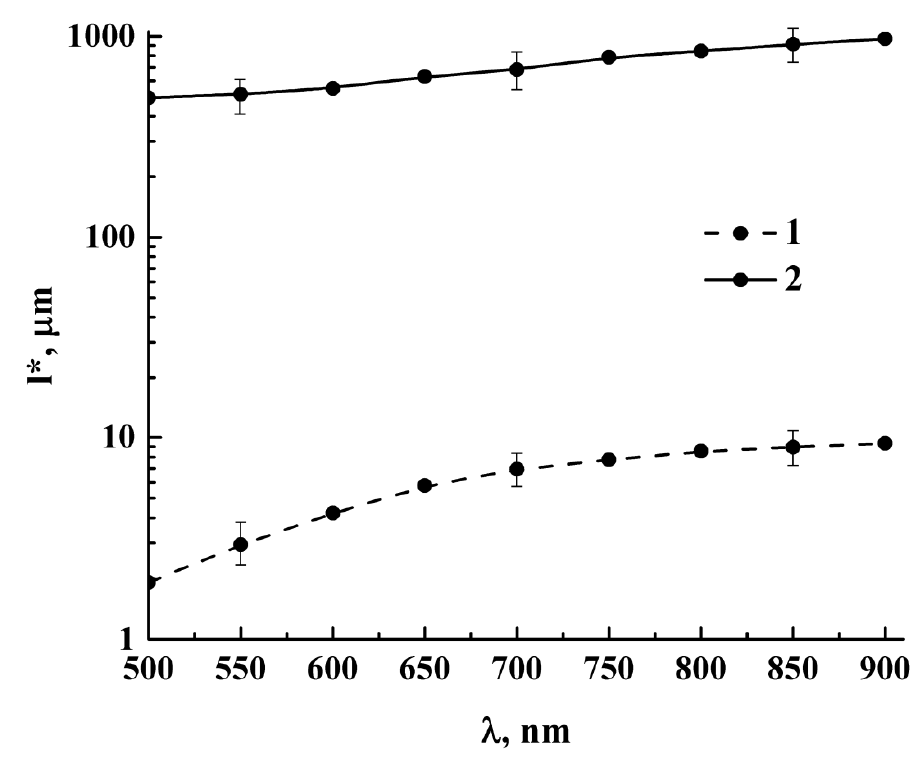
Figure 4. The recovered spectral dependencies of the transport mean free path for the examined systems in the wet state. Selectively shown error bars correspond to a confidence level of 0.9.